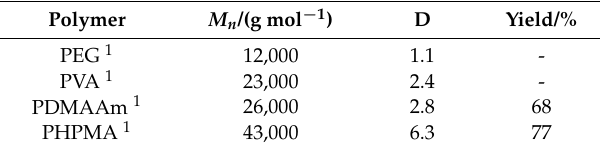
Table 1. Characterization of the used homopolymers.